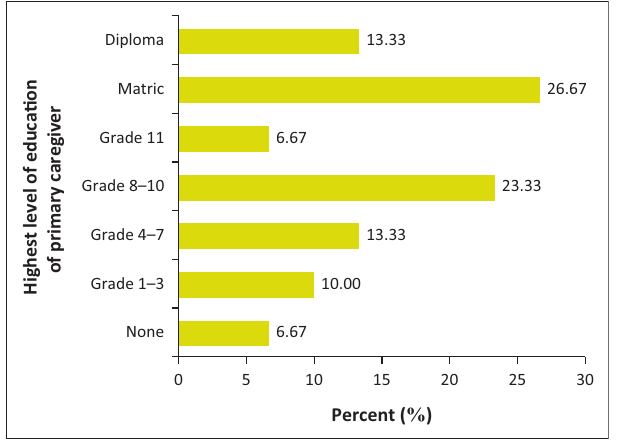
FIG URE 1: The primary parent or guardian’s highest level of education ( n = 30). TABLE 2: Individual components of the Movement Assessment Battery for Children - 2 scores classified into zones (traffic light system) ( n = 30). Factors of